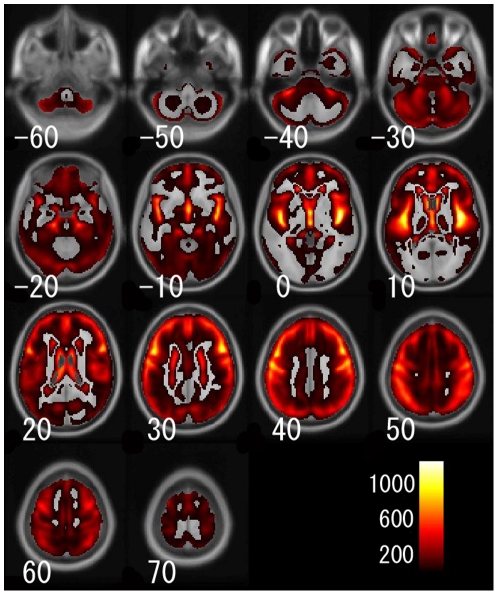
Gray matter regions that showed a significant main effect of age on regional gray matter volume.The left side of the image represents the left side of the brain. Color scales indicate the F-score. The number at the bottom of the left side of each image indicates the value of the z-axis in the Talairach stereotaxic space.